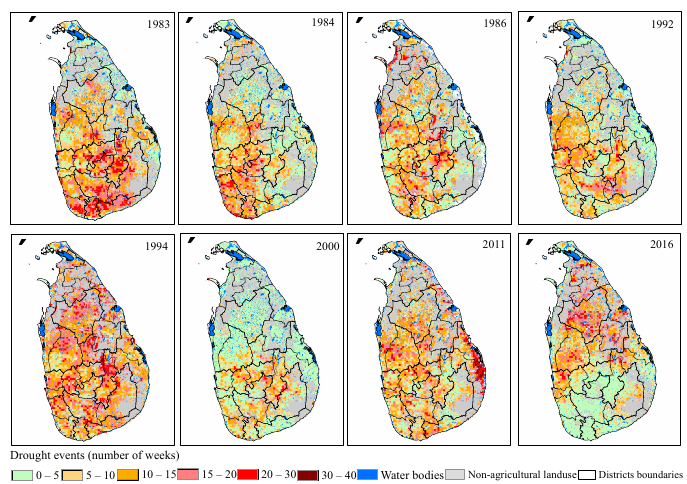
Figure 5. Historical drought years identified based on the number of severe to extreme drought weeks in each year.